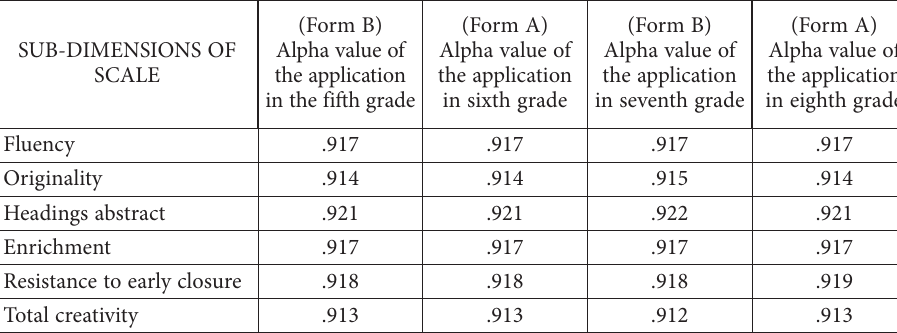
SUB-DIMENSIONS OF